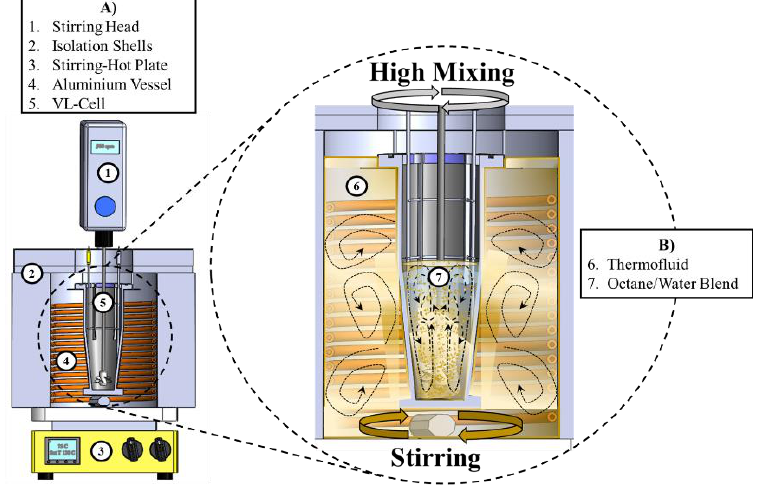
Figure 1. Chemical Reactors Engineering Center (CREC) vapor–liquid (VL) Cell: (1) Stirring head, (2) Isolation shells, (3) Stirring hot plate, (4) Aluminum vessel, (5) VL Cell, (6) Thermofield, (7) Octane/water blend.